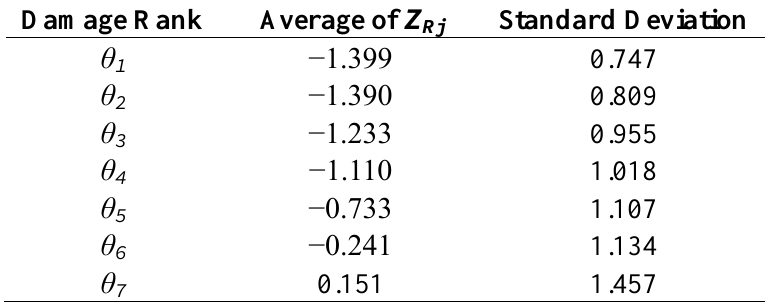
Figure 5. Modeled likelihood functions by discriminant score Z